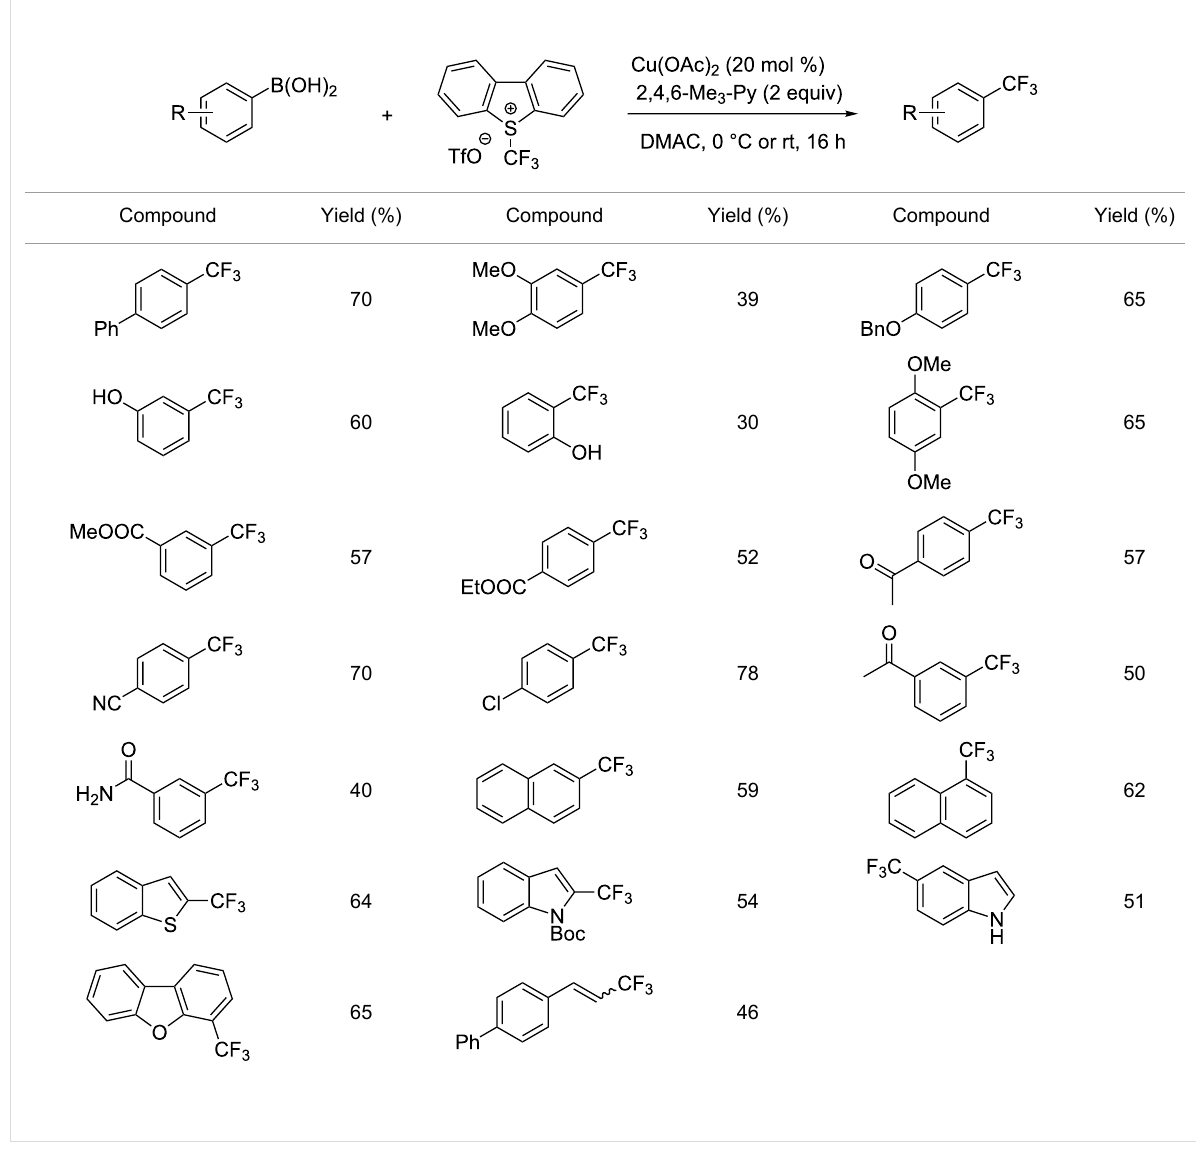
Table 23: Cu-catalyzed trifluoromethylation of aryl, heteroaryl, and vinyl boronic acids with Umemoto's trifluoromethyl dibenzosulfonium salt [93].